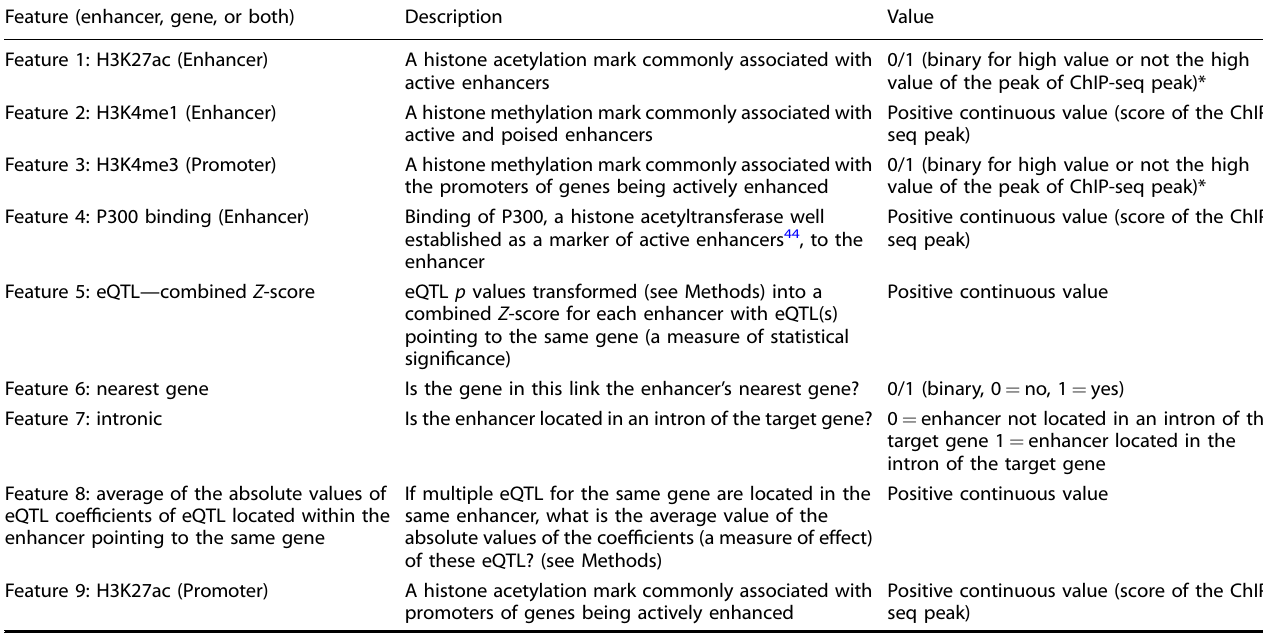
Table 2. Description of the main effect features.